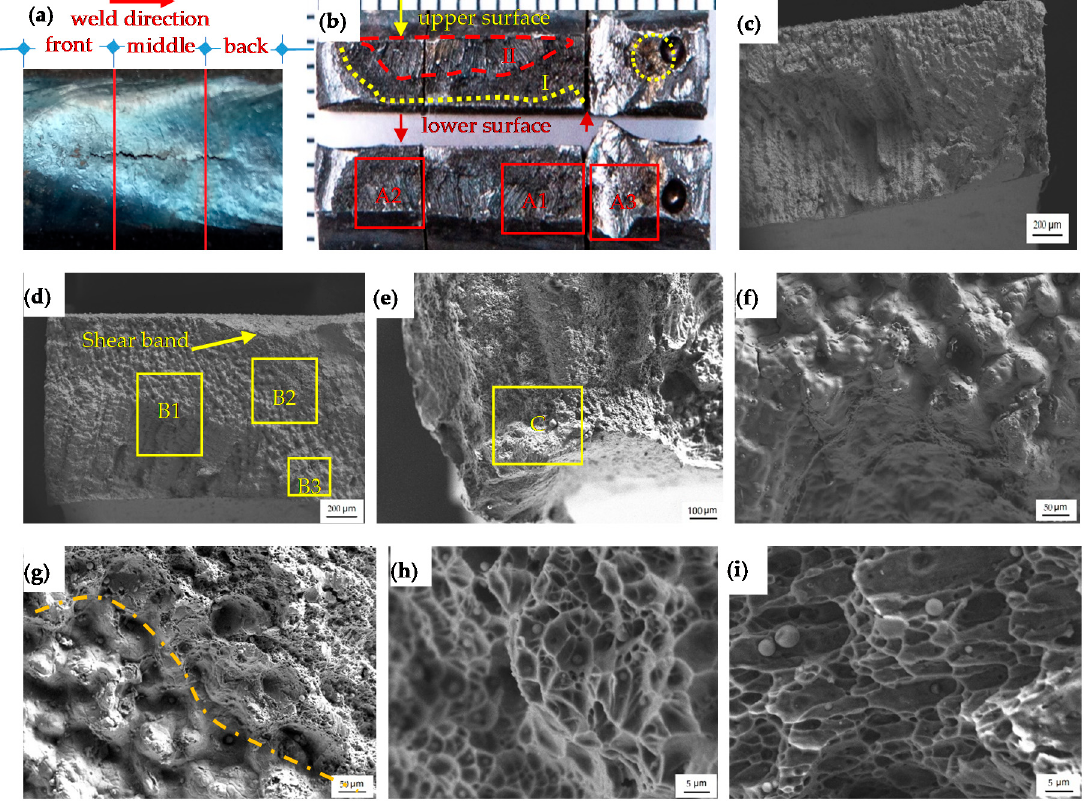
Figure 6. Solidification crack ( a ) appearance, ( b ) surface, and ( c – i ) A1, A2, A3, B1, B2, B3, and C magnifications, respectively.